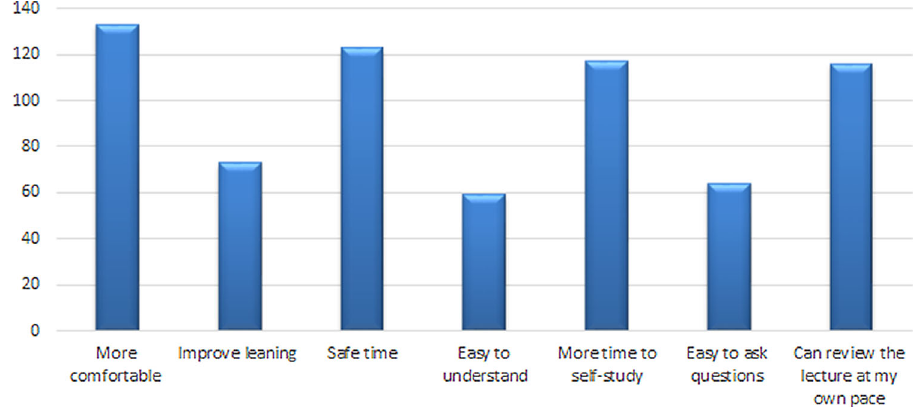
Figure 2. Responses of students for recommending E-learning in the future.